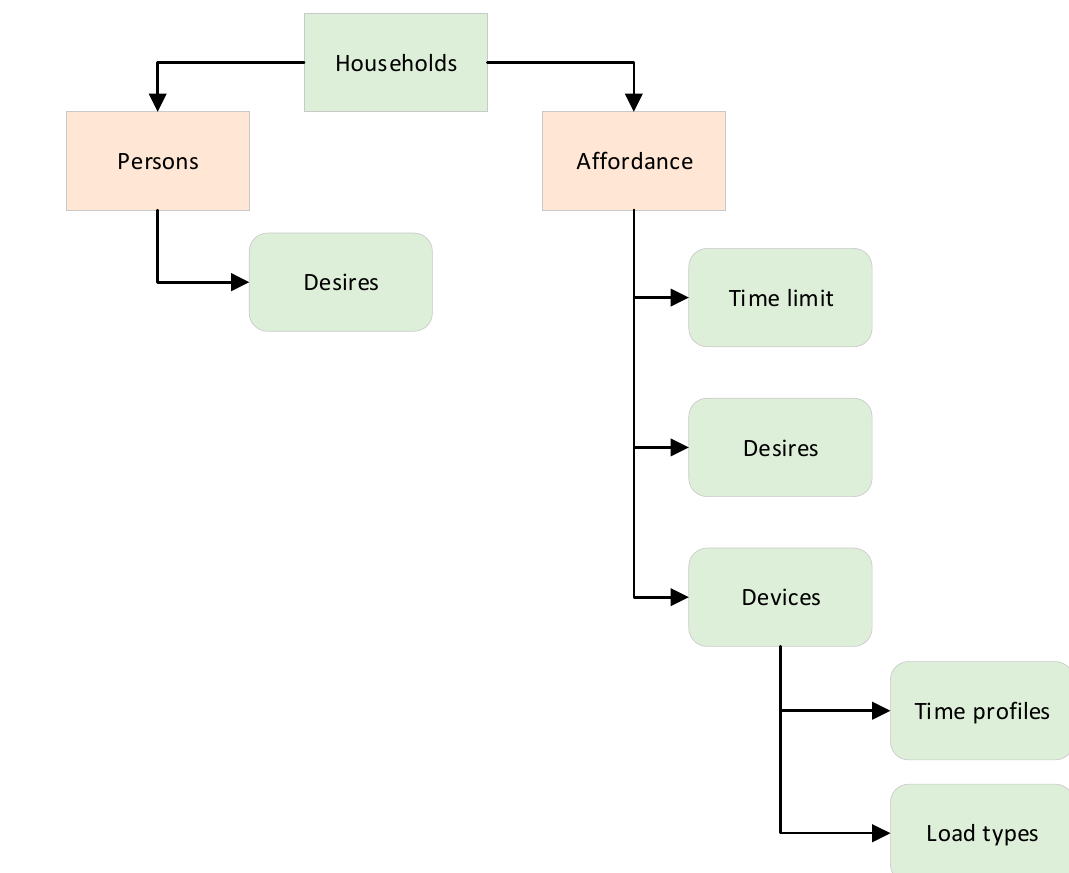
Figure 4. LPG’s minimum necessary elements in modelling a decision-making process of a single household [15], where the basic elements are the desire to do so and expressions of the need to do